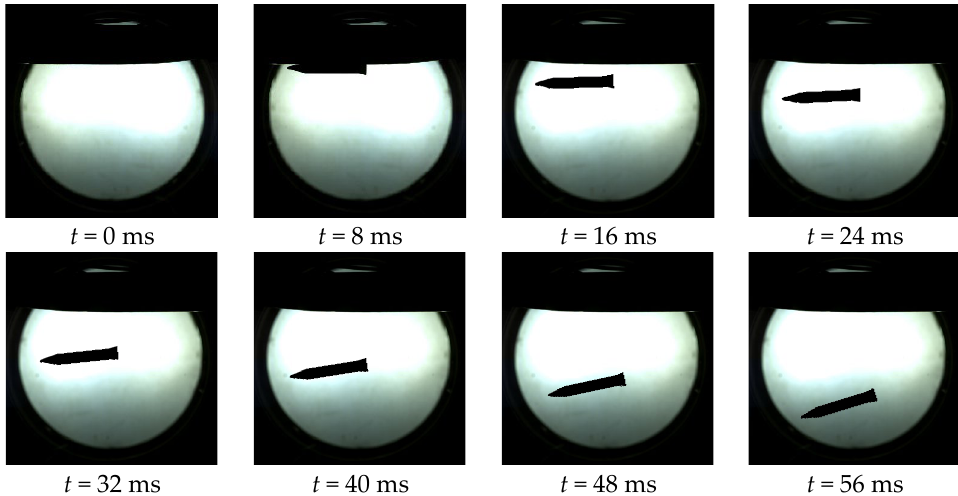
Figure 12. Test image of the revolution body’s angle of attack change without a jet at M = 0.6.